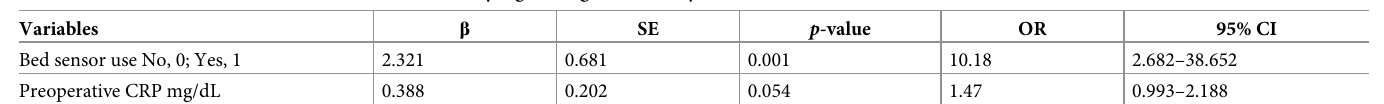
No delirium, n = 82